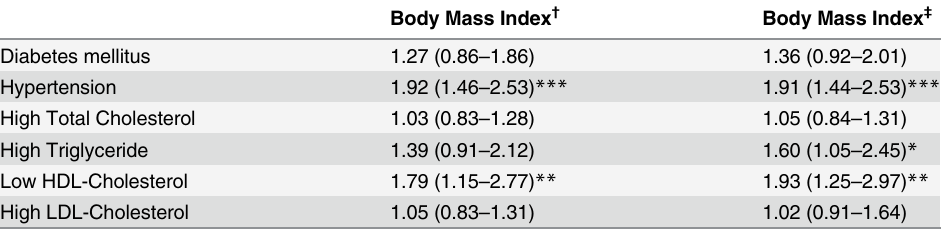
Table 6. Odds Ratio of Cardiovascular Disease Risk Factors Adjusted for Age, Gender, Ethnicity, Smoking Status, Physical Activity Status and Waist Circumference or Waist-Height Ratio (Model